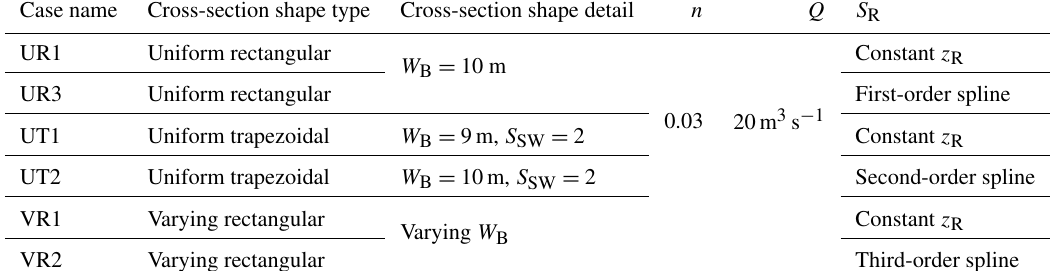
Table 1. Configuration and geometric data for analytical test cases derived from MacDonald et al. (1995). W B and S SW represent bottom width and sidewall slope, respectively.